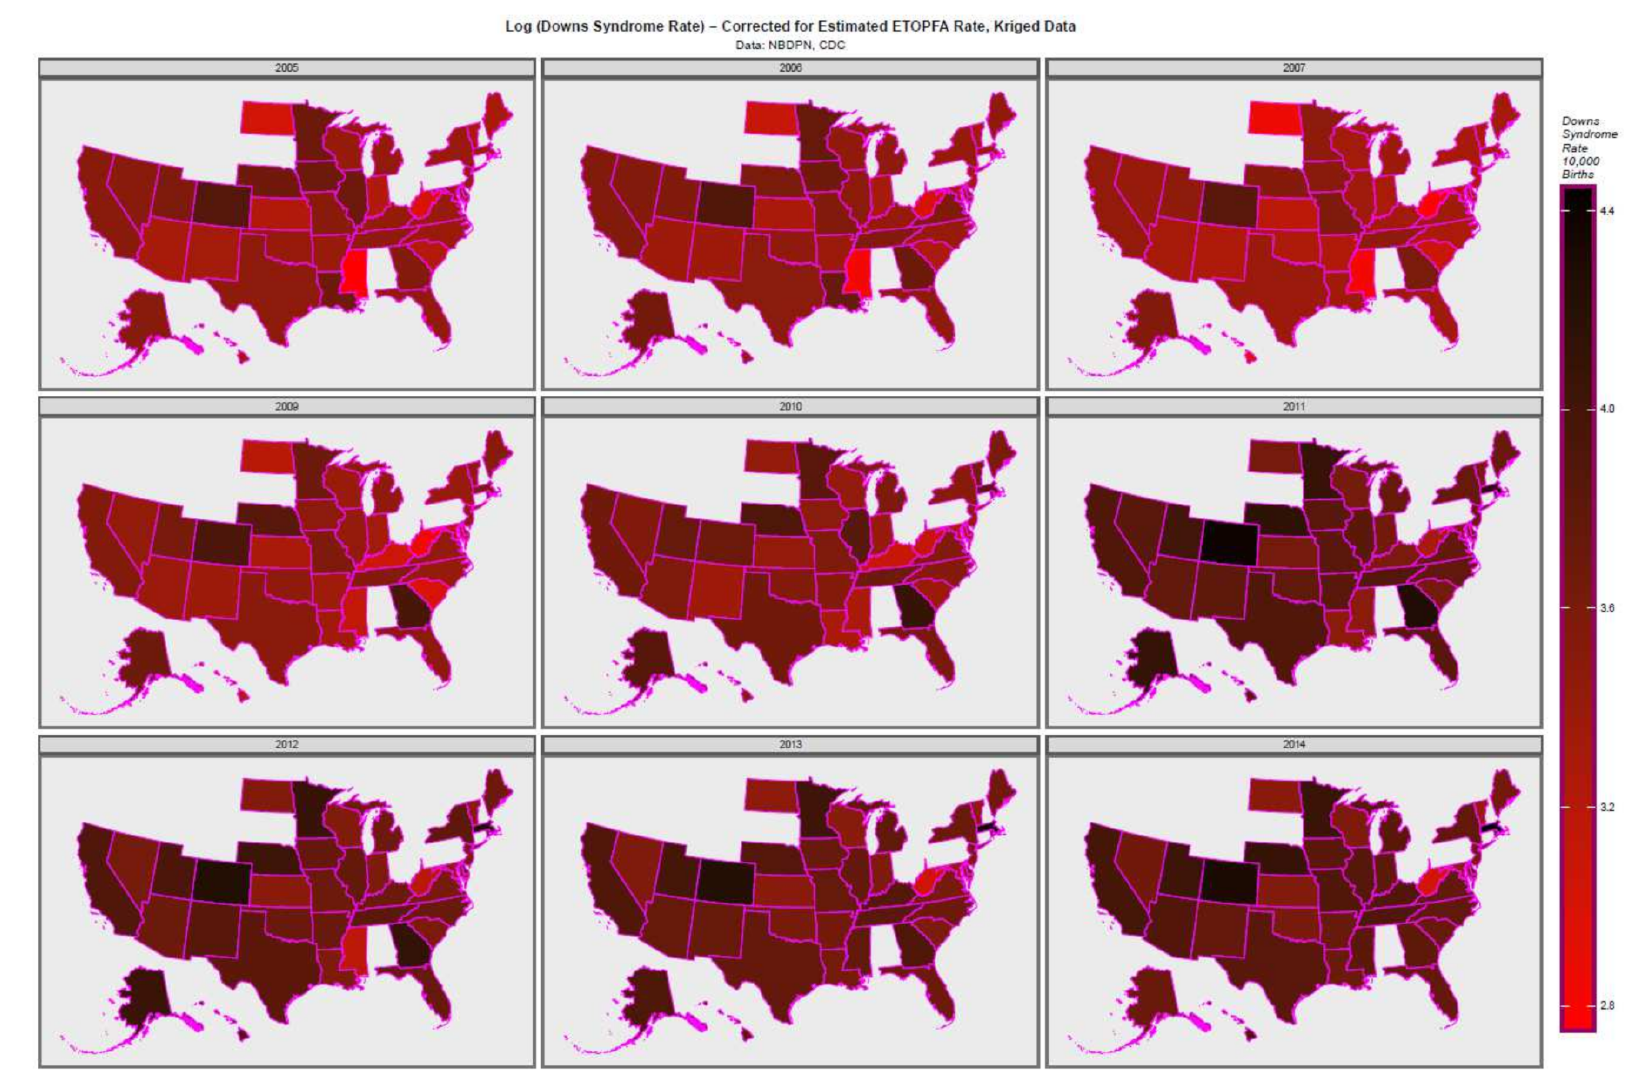
Figure 4. Log of ETOPFA-corrected Down syndrome rates across USA 2005–2014, kriged